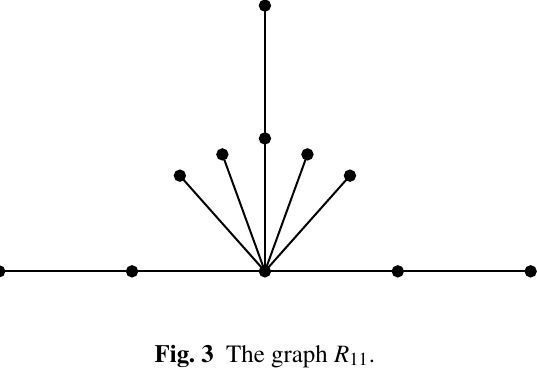
Fig. 3 The graph R 11